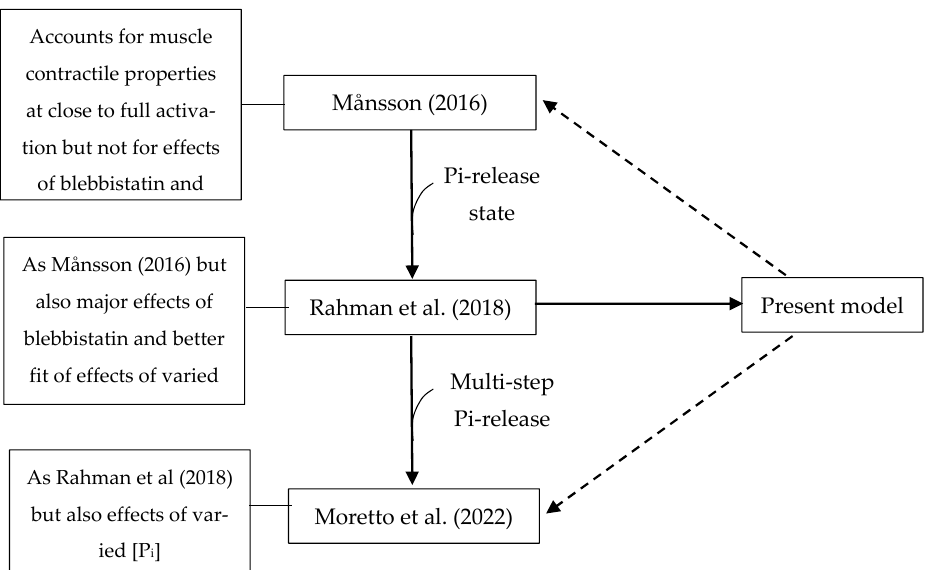
Figure 11. History of model and implications for related models. The model in Figure 1 is essen- tially the model of Rahman et al. (2018) [6] developed from the model of Månsson (2016) [5] to include a Pi-release state, allowing the model to account for most blebbistatin effects on actomyosin function and muscle contraction. The model of Rahman et al. [6] was then further modified with the inclusion of secondary Pi-binding sites outside the active site to account for a range of experimental observations at varied Pi levels, producing the model of Moretto et al. (2022) [85]. Importantly, the modifications of the model of Rahman et al. (2018) to produce the present optimized model should also be readily implemented (dashed arrows) in the models of Månsson (2016) and Moretto (2022).